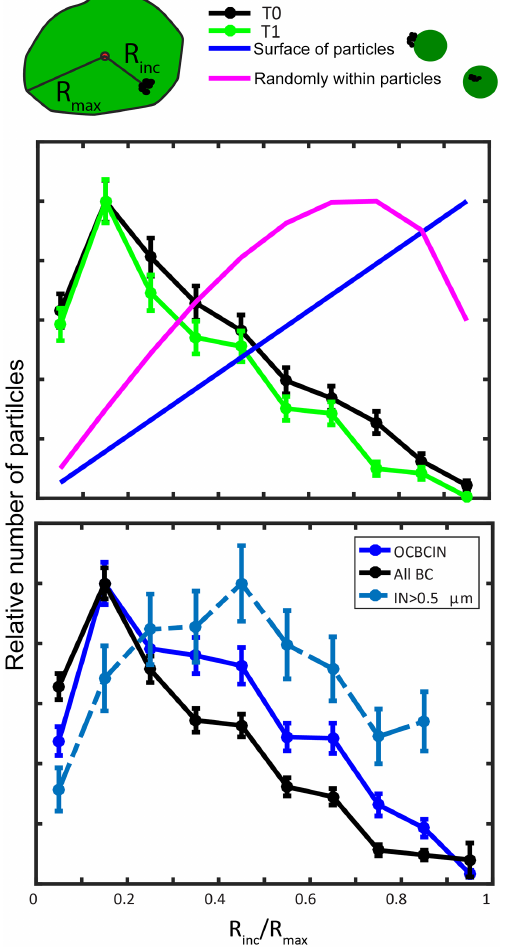
Figure 7. (Top) Distance of the BC inclusions from the center to the host particle for the CARES field study at the T0 (black) or T1 (green) sites. The distance of the BC inclusion ( R inc ) is normalized to the distance from the particle center of mass to the farthest edge ( R max ) (see illustration above plot). Modeled locations of BC inclu- sions are shown assuming the inclusion was on the surface (blue) or randomly within the host particle (magenta) before impaction. (Bottom) Distance of BC inclusion from the host center for all BC containing particles (black), OCBCIN particles, and particles con- taining inorganic inclusions (IN) having a geometric diameter larger than